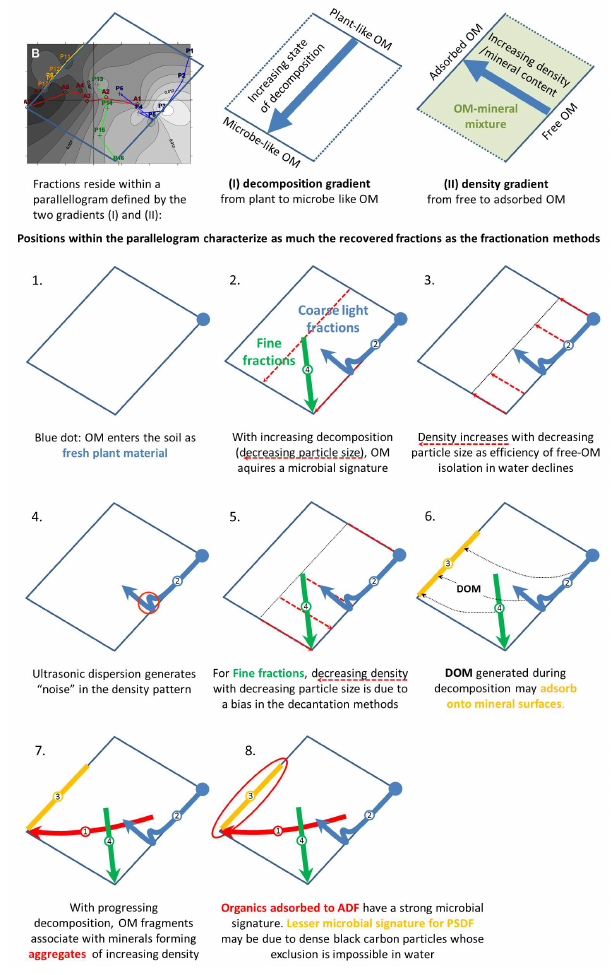
Fig. 7. Interpretative schemes of the PCA analysis presented in Fig. 4. Meanings of arrows are describes in Fig. 5. The green zone in the upper right scheme represents a zone where fractions must be composite (i.e. composed of elements that can be both aggregated and